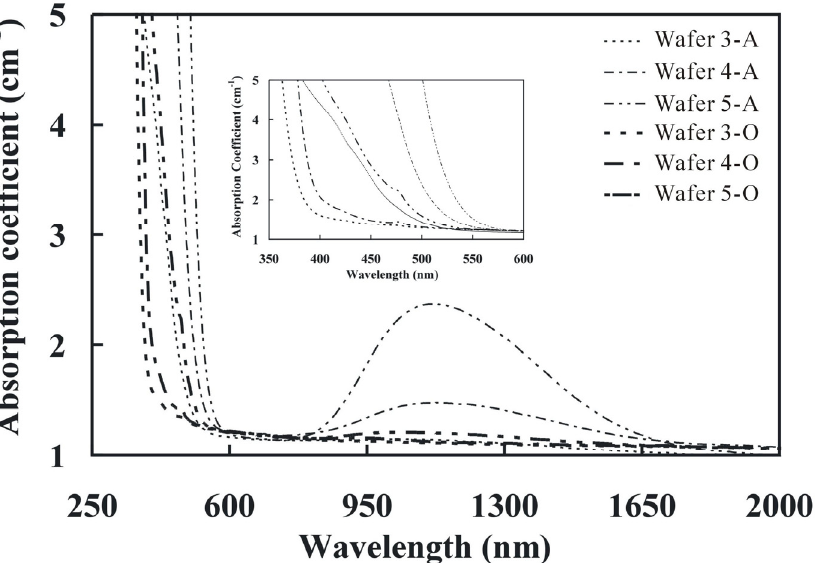
Figure 3. Absorption spectra of the as grown (A) and oxidized (O)